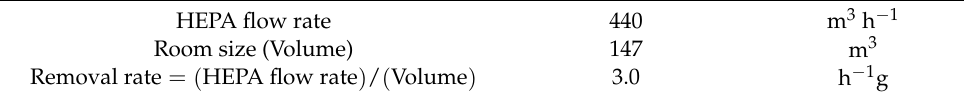
Table 7. Virus removal rate for a portable HEPA